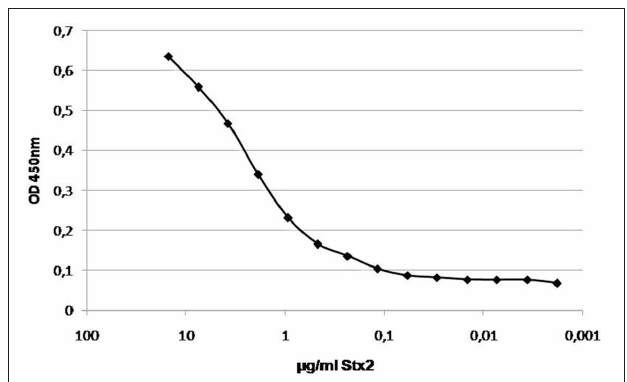
FIGURE 2 | Titration curve of purified Stx2 by anti-Stx2B IgY sandwich ELISA. The reaction was carried out using anti-Stx2B IgY followed by serial twofold dilutions of purified Stx2 and incubation with horseradish peroxidase-conjugatedanti-Stx2B IgG. The detection limit was calculated from the mean + 3 SD of the blank control.